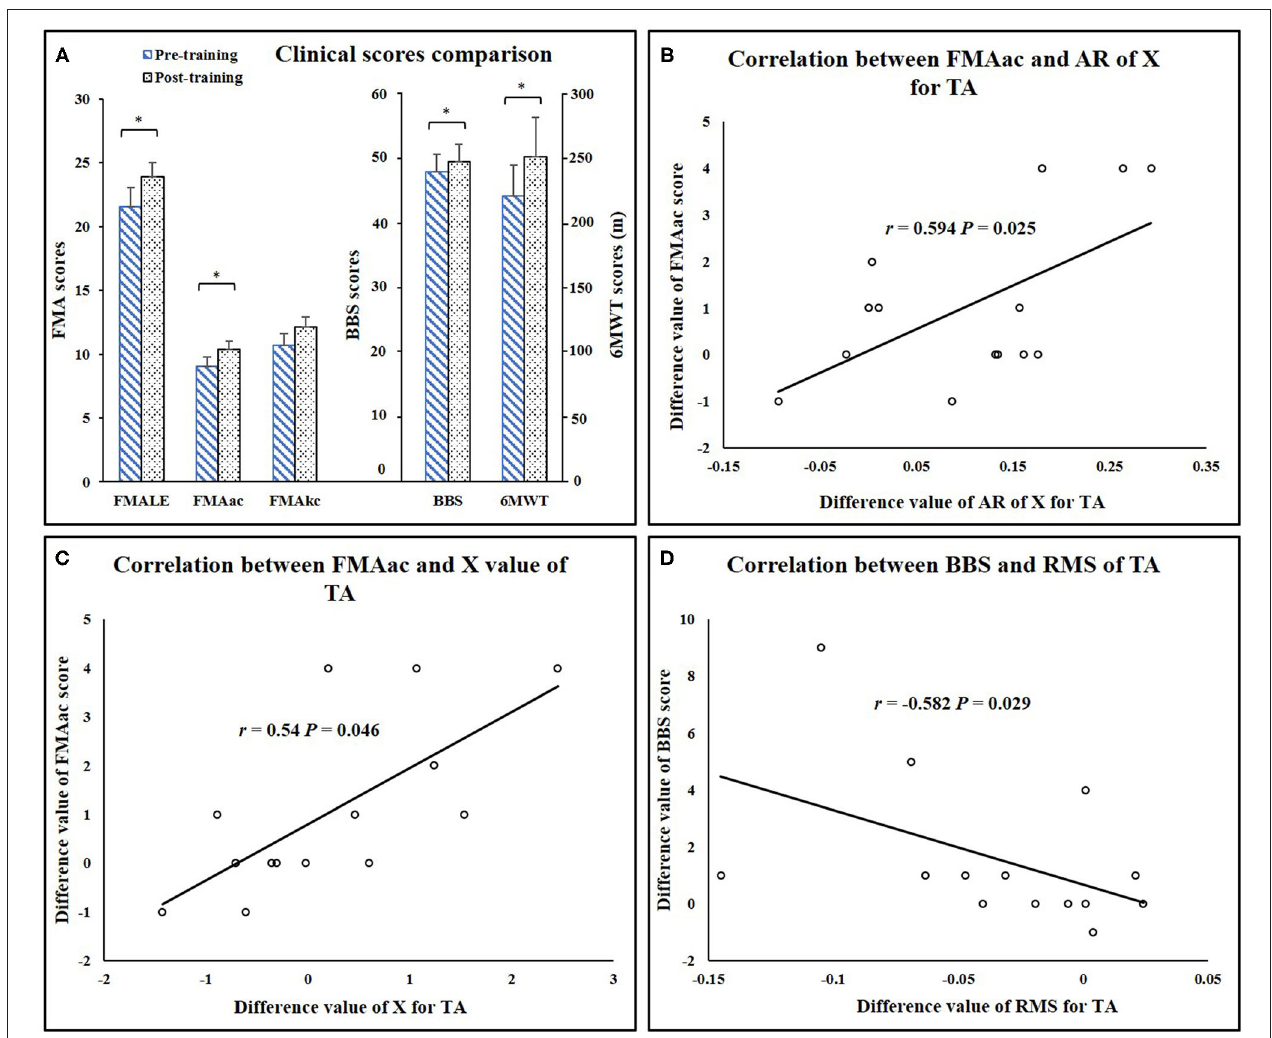
FIGURE 7 | (A) Clinical score comparisons. (B) Correlation between FMAac and AR of X value for TA. (C) Correlation between FMAac and X value of TA. (D) Correlation between BBS and RMS value of TA. AR, anisotropy ratio; RMS, root mean square; TA, tibialis anterior; FMA-LE, Fugl-Meyer assessment of lower extremity; FMAac, Fugl-Meyer assessment of ankle joint and coordination segments; FMAkc, Fugl-Meyer assessment of knee joint and coordination segments; BBS, Berg Balance Scale; 6MWT, 6-minute Walking Test. * P <